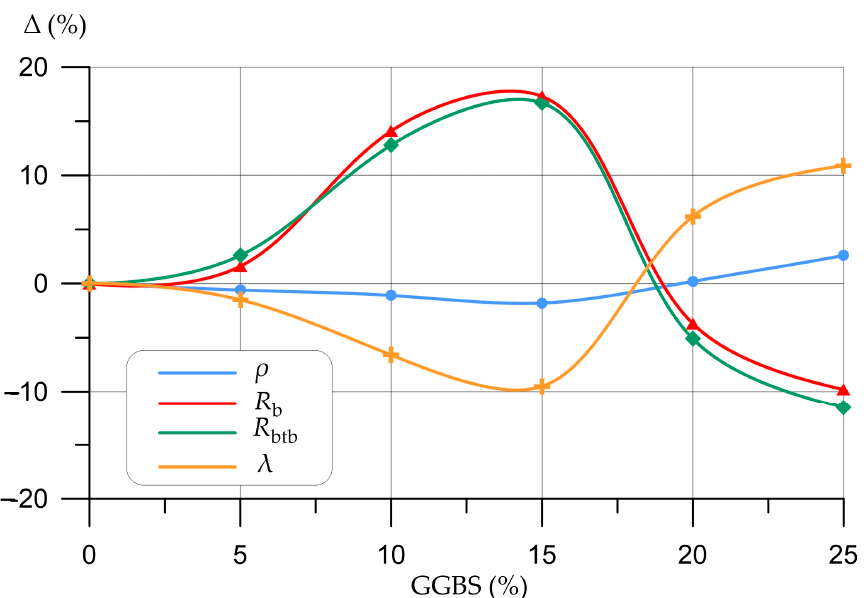
Figure 9. Trends in the physical and mechanical characteristics of non-autoclaved aerated concrete modified with different content of the GGBS additive.